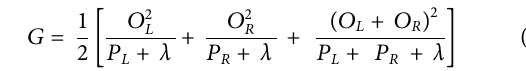
Frontiers in Earth Science |